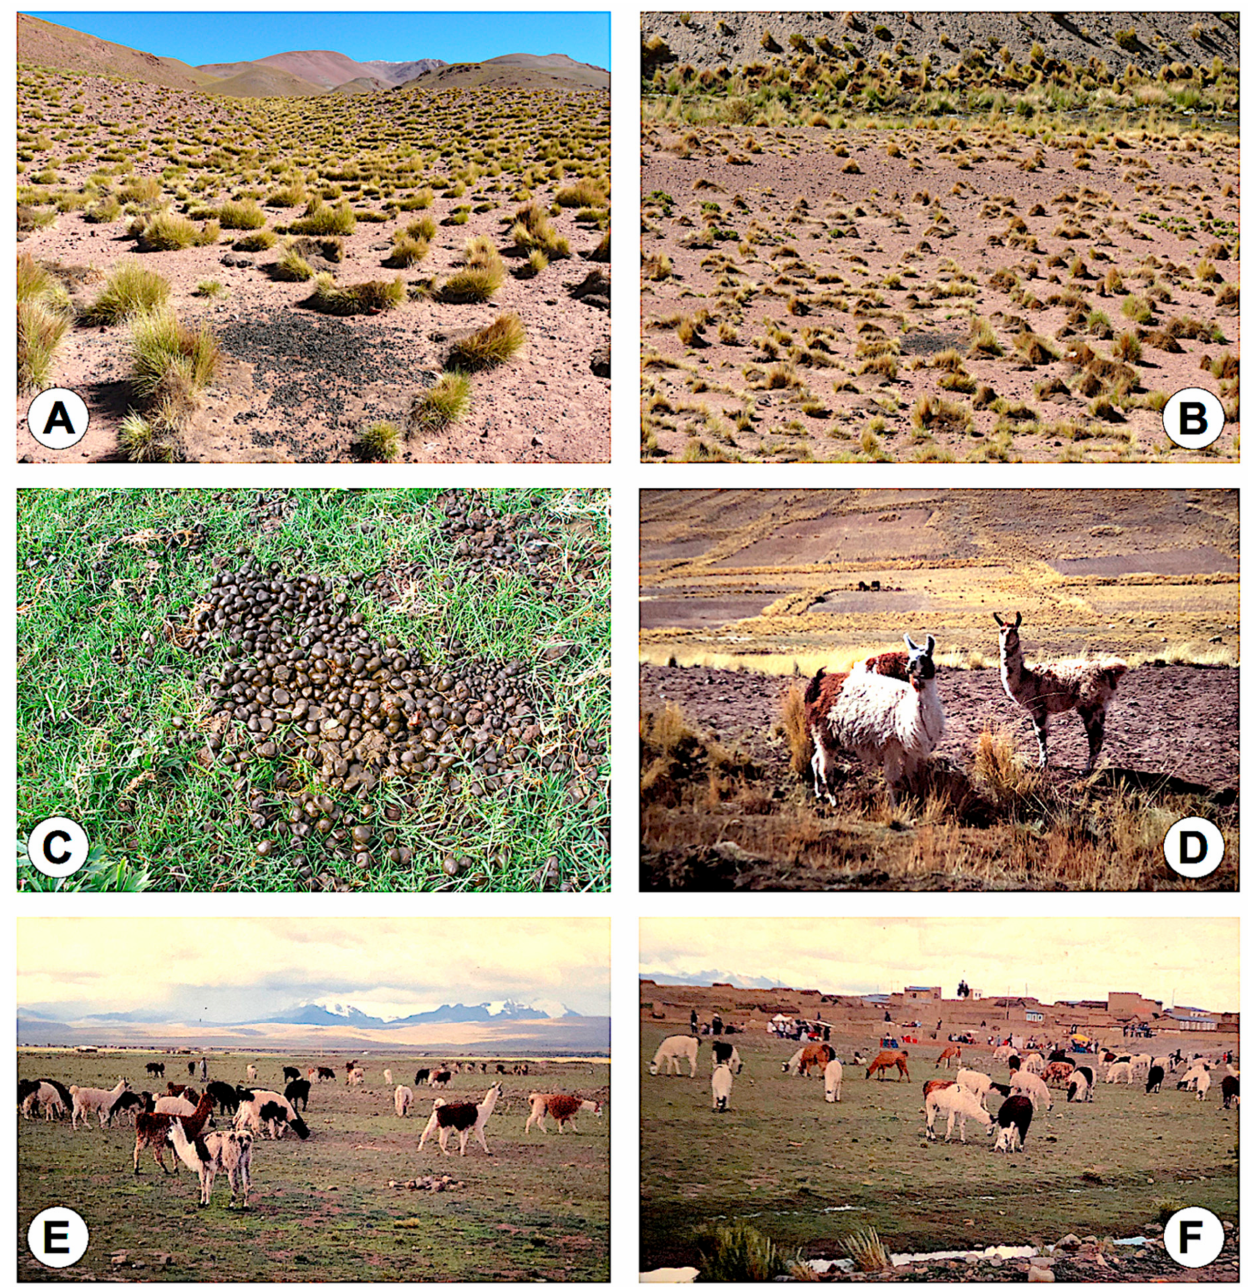
Figure 6. Llamas in the Argentine high Andean plateau and the Northern Bolivian Altiplano: ( A ) Typical dung pile in an Argentine Andean highland prairie; ( B ) Another dung pile located far away from small stream that rises from the slope sources in an Argentine Andean highland prairie (see background); ( C ) Dung pile showing fecal particles of llama commonly called “llama beans”; ( D ) Llamas in the northeastern part of the “corridor of Peñas” (see slope of the mountainous foothills of the Eastern Andean chain in the background and note surrounding aridity and absence of freshwater collections); ( E , F ) weekly trade fair of llamas in the locality of Palcoco in the Northern Bolivian Altiplano (note the absence of big “llamas cargueras”). ( A , B ): Photographs by A.J. Mangold; ( C ): Photograph by M.M. Cafrune; ( D – F ): Photographs by S.